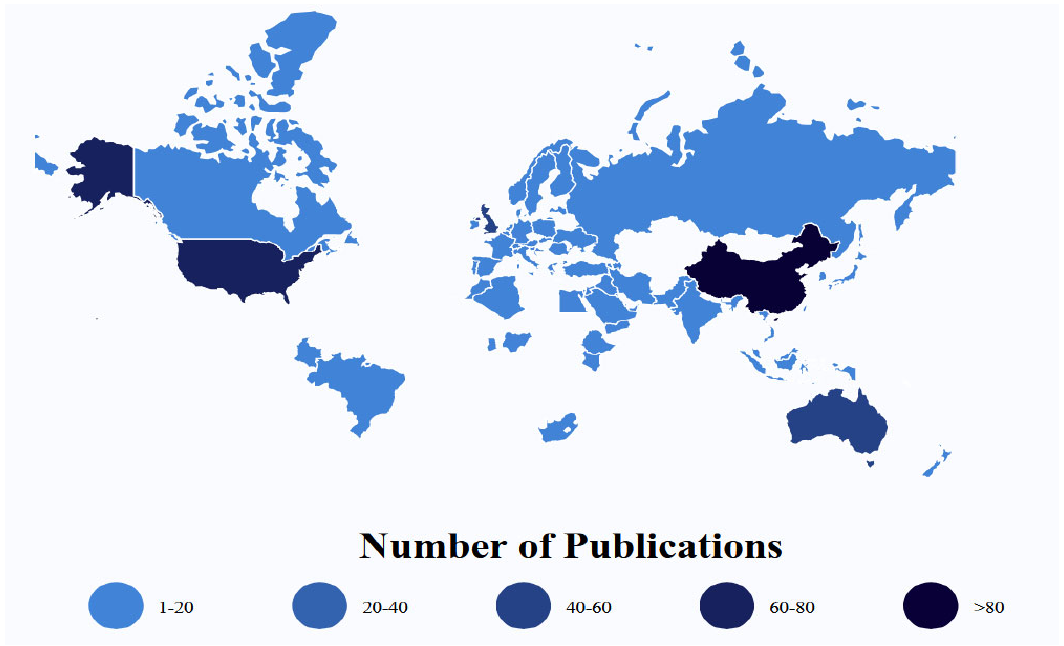
Figure 8. Papers’ distribution across the globe.